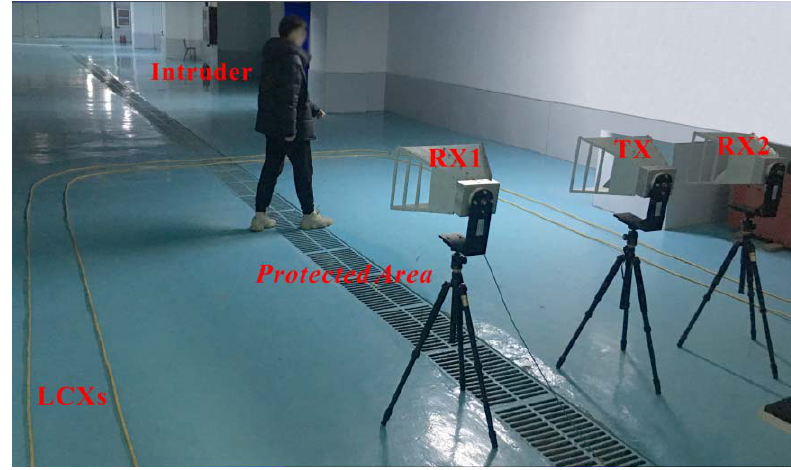
Figure 2. Experimental scene of the intruder entering the protected area.